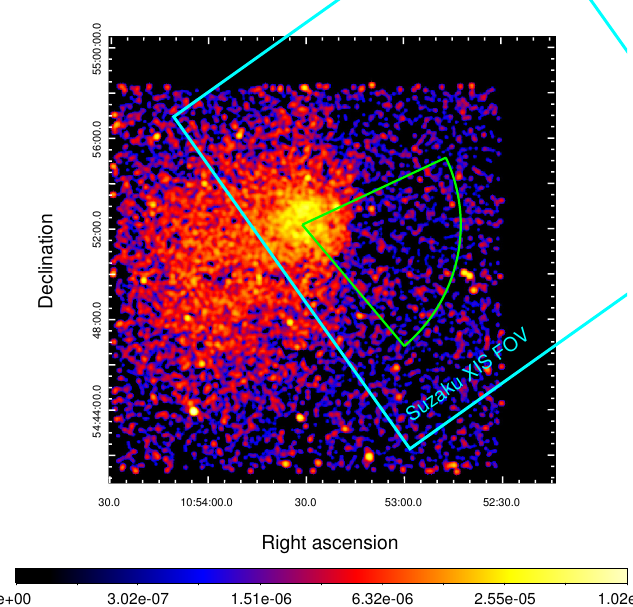
Figure 5. An X-ray image of the RXC J1053.7+5453 taken by Chandra in the 0.5–2.0 keV band from [7]. The green sector region is utilized to make the surface brightness profile across the edge.